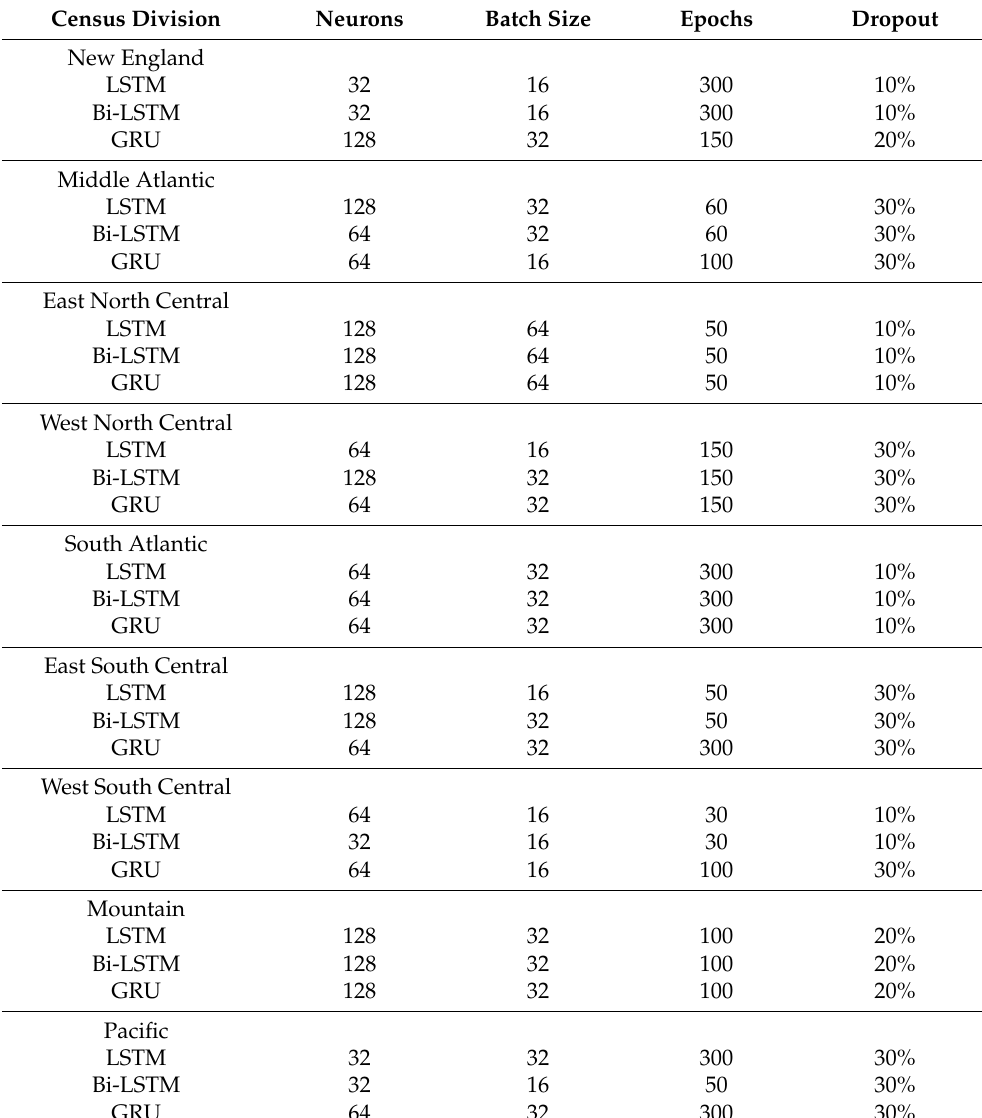
Table 6. The number of neurons, batch size, epochs, and dropout percent for the male database by